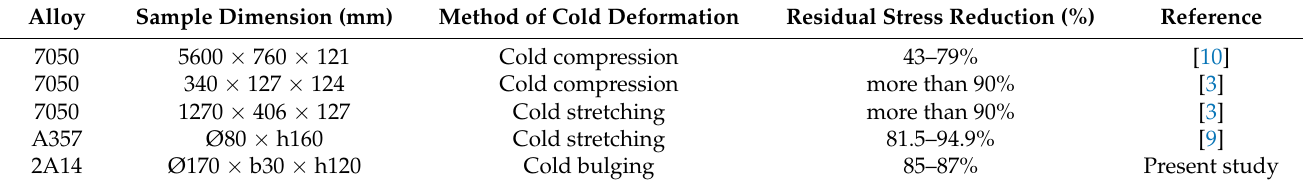
Table 5. The results of residual stress reduction via cold working presented by other researchers. Alloy Sample Dimension (mm) Method of Cold Deformation Residual Stress Reduction (%)